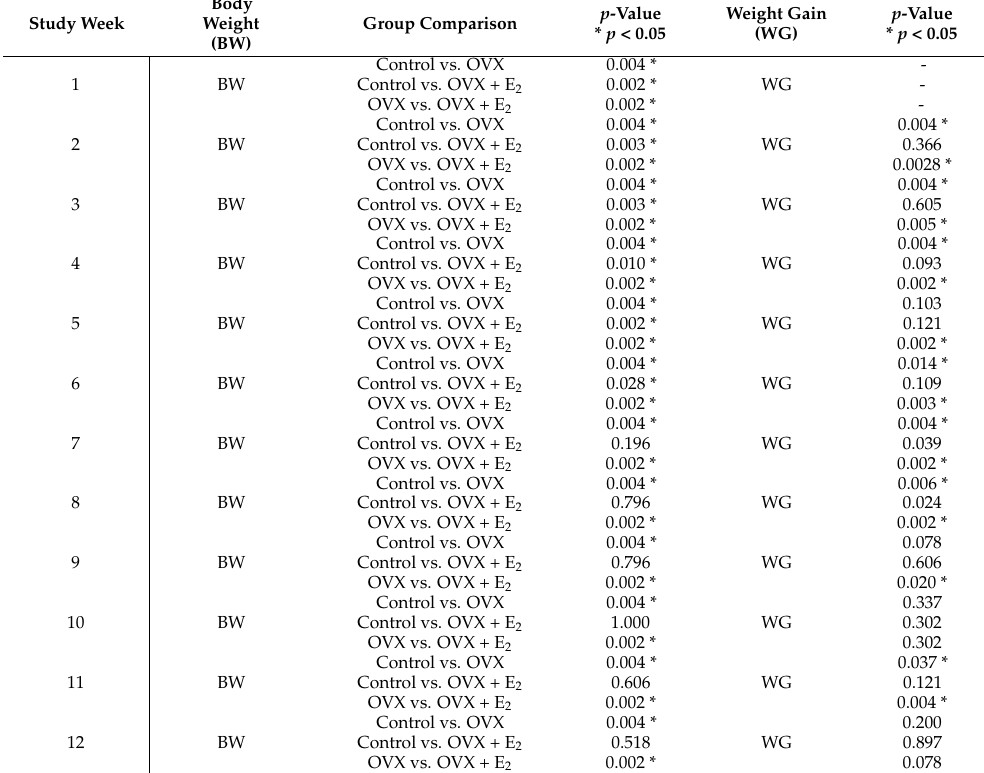
Table 4. A statistical comparison of body weight (BW) and weight gain (WG) in each of the groups. p < 0.05 were considered significant.